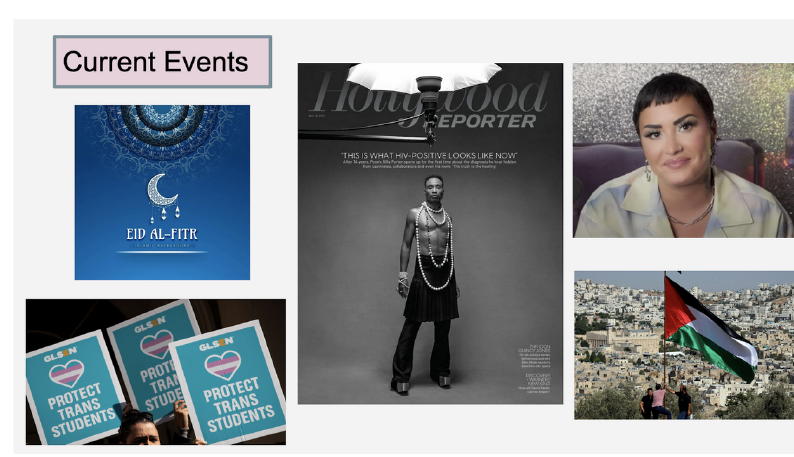
IMAGE 3: EXAMPLE OF POPULAR CULTURE AND CURRENT EVENTS